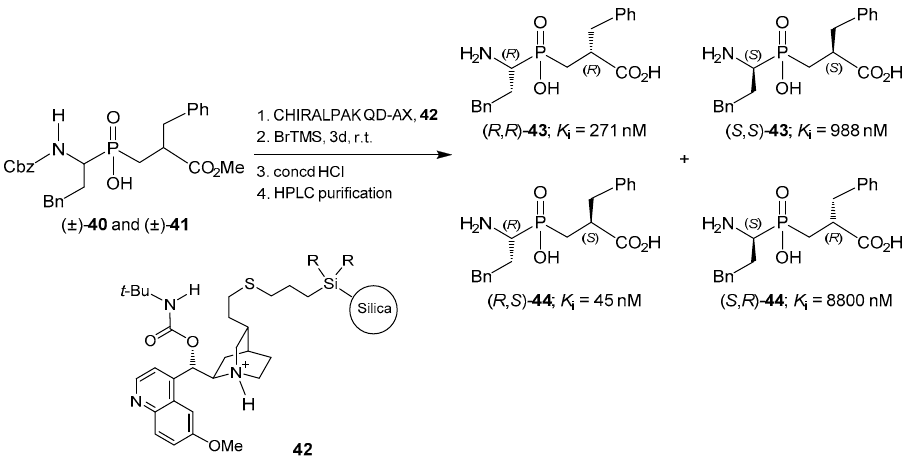
Scheme 23. Chiral HPLC separation of phosphinic dipeptide derivatives 40 and 41 and activities of unprotected derivatives 43 and 44 as inhibitors of leucine aminopeptidase (LAP). unprotected derivatives 43 and 44 as inhibitors of leucine aminopeptidase